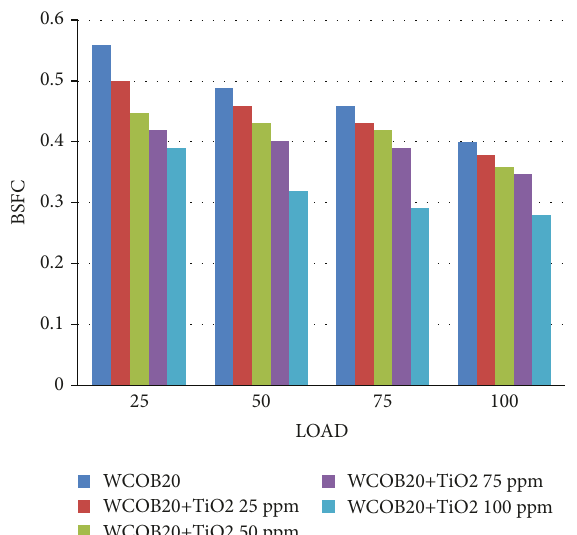
Figure 7: Brake specific fuel consumption with respect to engine load.